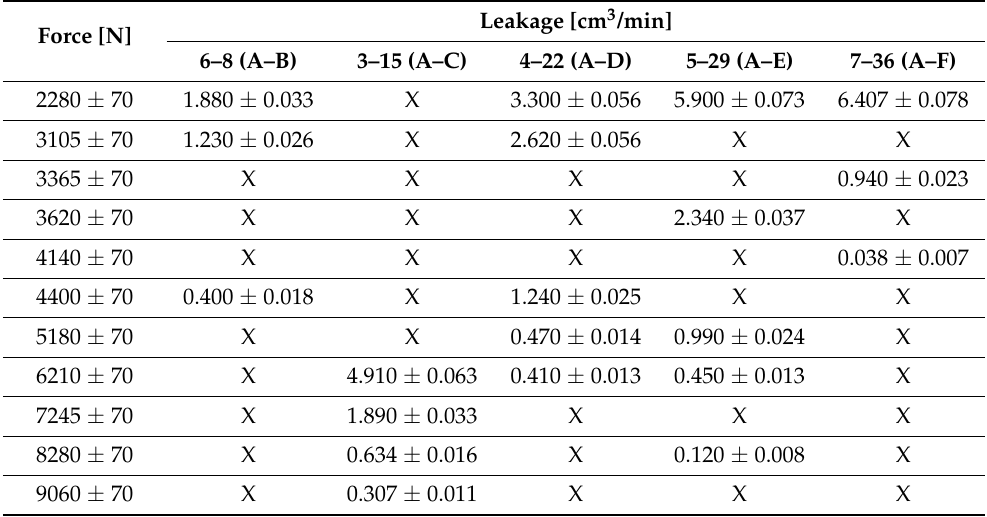
Table 8. Forces and leakage for a pair of samples with surface topography parameters from code groups A, C, D, E, and F.